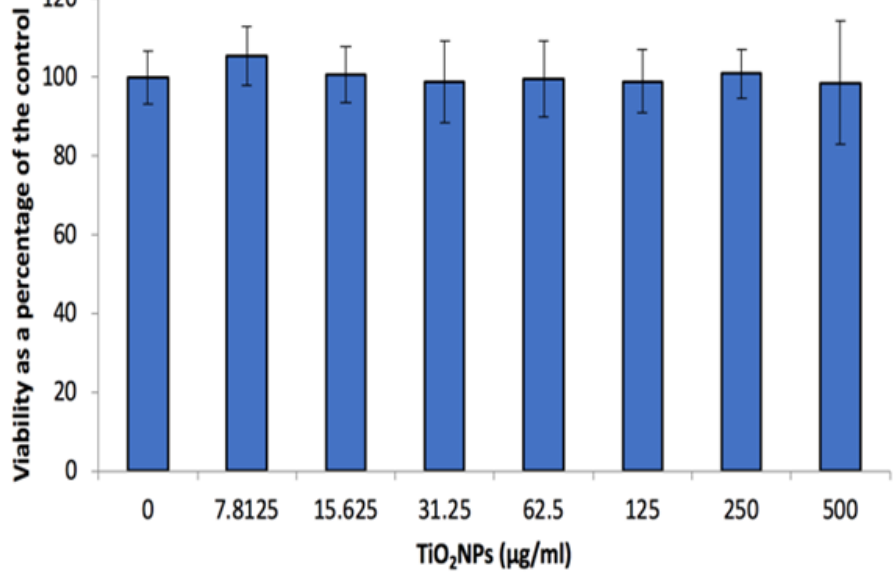
Figure 3. Caco-2 cell viability after 48 h exposure to a range of TiO 2 NP concentrations. Data represented as mean ± SD.